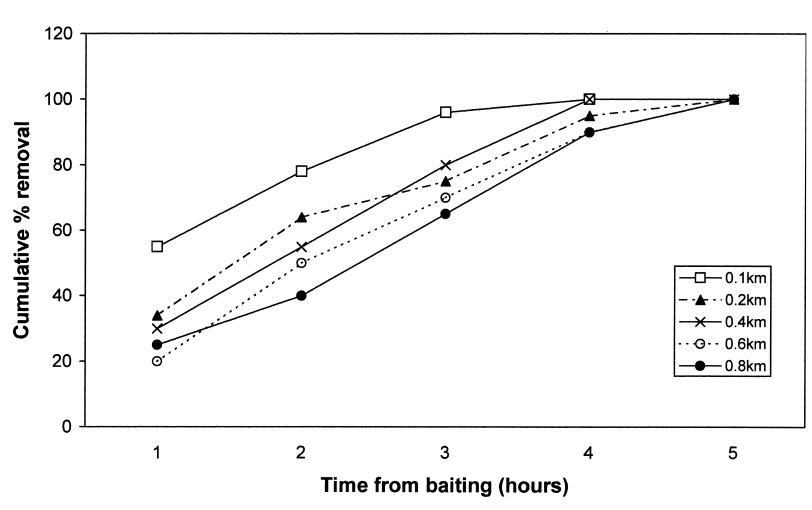
Fig. 4. Graph showing the effect of spacing between baits on rate of removal. Each line is the mean of at least 3